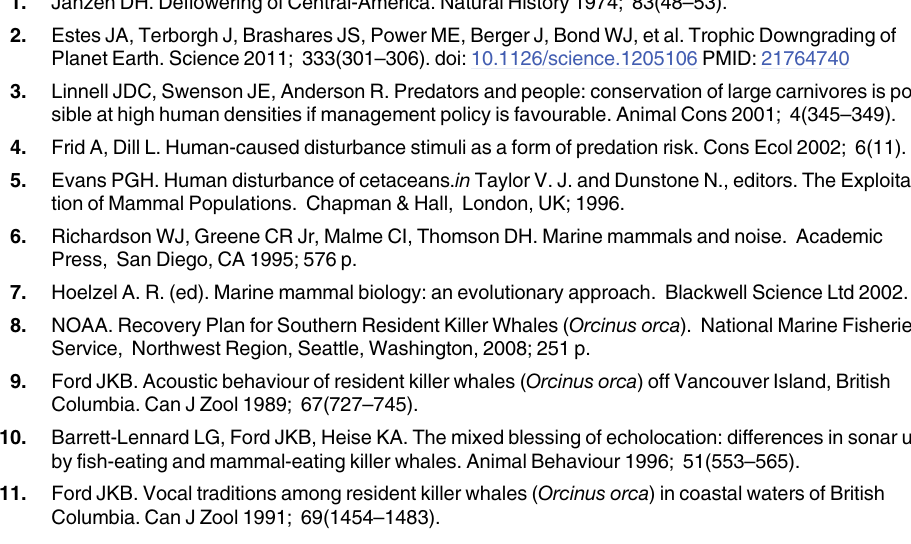
S8 Fig. Average vessel length and average vessel type. The average vessel length (m) had a highly significant correlation with average vessel type per interval (F S9 Fig. Average number of propellers and average vessel speed. The average number of pro- pellers had a marginally significant correlation with average vessel speed per interval (F 3.385, p = 0.071). S1 Table. AICc results of models with qualitative characteristics as factors. Negative log like- lihood model results when vessel type, propulsion system and orientation were included as fac- tors. The AICc value for the full model excluding research vessel-only intervals where each qualitative characteristic was assigned a numerical value (according to Table 1) was